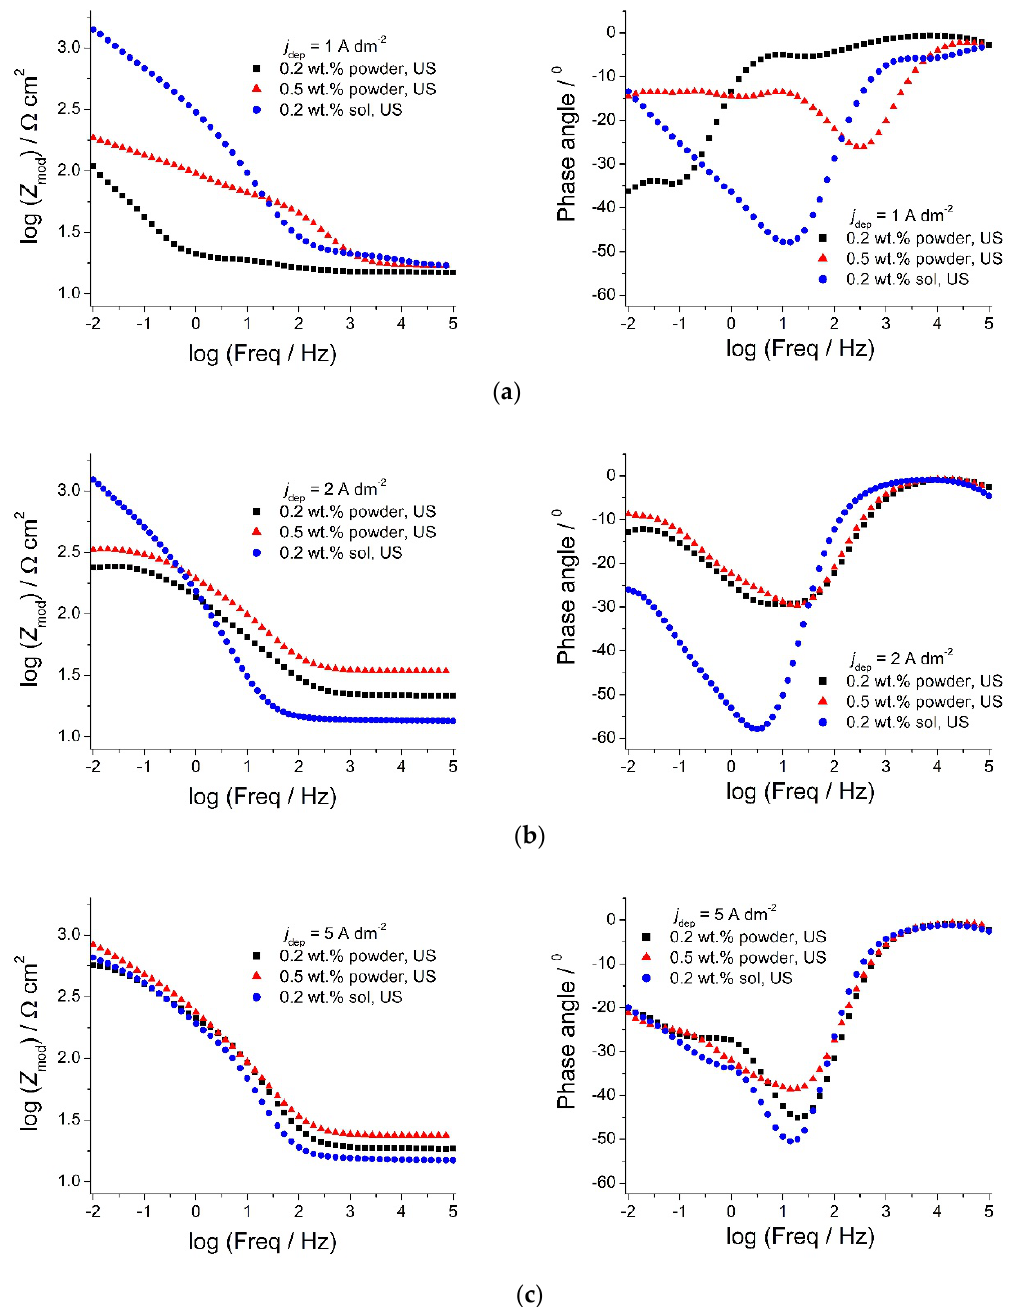
Figure 14. Bode plots of Zn-Co-CeO 2 composite coatings deposited under ultrasound: influence of different deposition current densities: ( a ) 1 A dm − 2 , ( b ) 2 A dm − 2 , and ( c ) 5 A dm − 2 and ceria sources on corrosion properties.